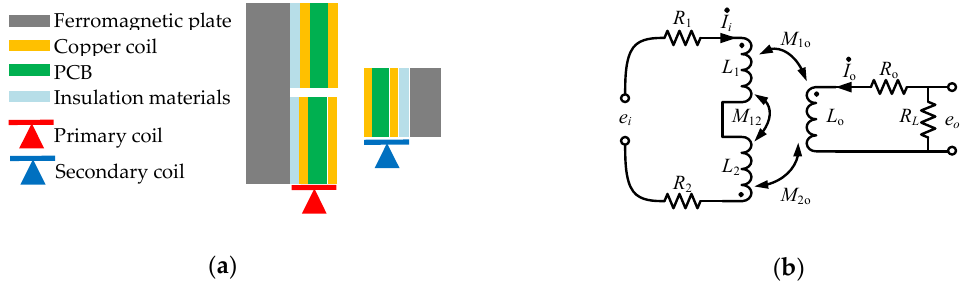
Figure 2. ( a ) Cross section scheme of the sensing element. ( b ) The equivalent circuit of the Figure 2. (a) Cross section scheme of the sensing element. (b) The equivalent circuit of the sensing sensing element.